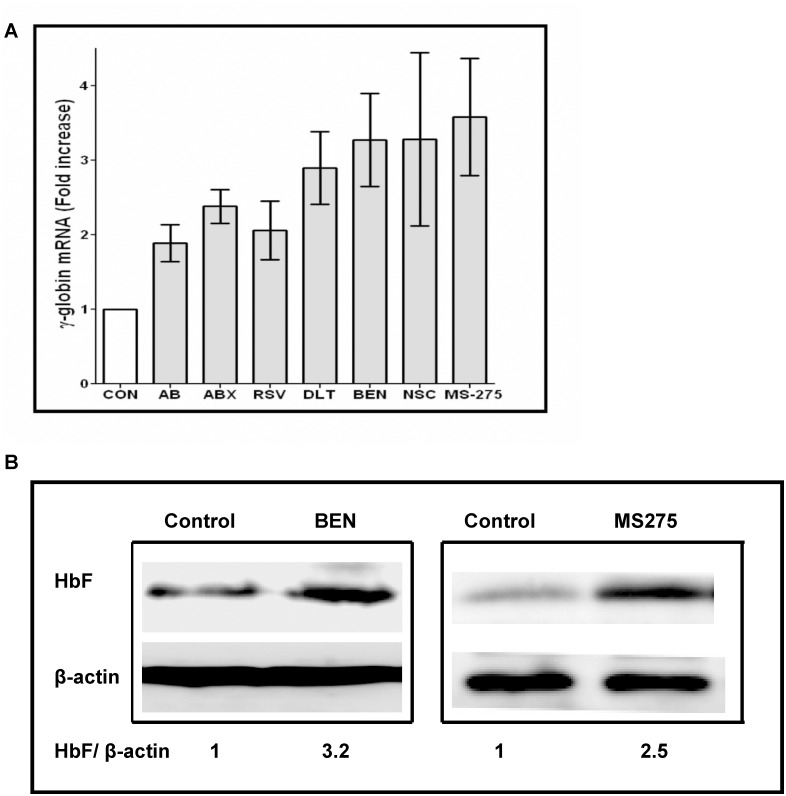
γ-globin mRNA induction in human erythroid progenitors treated with therapeutic candidates.(A.) Mean fold-induction of γ-globin mRNA with addition of Ambroxol (ABX), resveratrol (RSV), Desloratadine (DLT), NSC-95397 (NSC), MS-275, or Benserazide (BEN), compared to vehicle-treated control (Con) in erythroid progenitors from the same subject and to arginine butyrate (AB)-treatment. The range in γ-globin mRNA induction from 2.4- to 4-fold, compared to the subject’s baseline was statistically significant for all candidates and exceeded induction of γ-globin mRNA compared by butyrate (AB) in the same cultures. Error bars indicate standard deviation (SD). (B.) Western blot demonstrating HbF protein induction in erythroid cells treated with therapeutic candidates. HbF protein relative to beta actin is shown below the bands. HbF increased above the ratios in control cells from the same source, by 3.2-fold with Benserazide treatment and by 2.5-fold with MS-275 treatment.